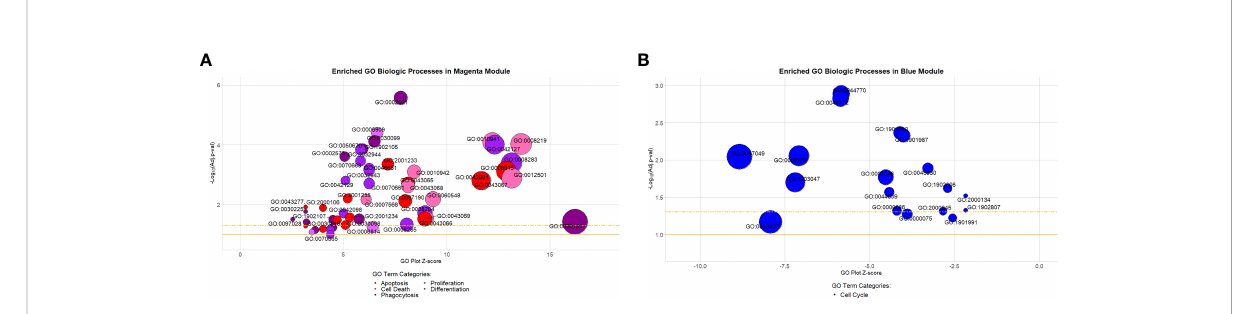
FIGURE 2 Gene ontology biologic processes enriched in the preserved magenta and blue modules. (A) Highlighted processes in the magenta module are associated with apoptosis, cell death, differentiation, phagocytosis, and proliferation. They comprised approximately 9% (53/587) of all signi fi cantly enriched processes within the module (Benjamini-Hochberg adjusted [BH-adj] p-value < 0.1). (B) Highlighted processes in the blue module are all associated with the cell cycle. They comprised approximately 24.7% (18/73) of all signi fi cantly enriched processes within the module (BH-adj p-value < 0.1). Description of GO terms are available in Supplemental Tables S3A (magenta) and S3B (blue). Bubble plot y-axis represents biologic process signi fi cance (-Log 10 adjusted p-values) and x-axis represents the GO plot Z-score indicative of the likelihood that a biologic process is up (positive value) or downregulated (negative value). The gold solid horizontal line on the bubble plot represents a BH-adj p-value = 0.1 and the gold dashed horizontal line represents a BH-adj p-value =